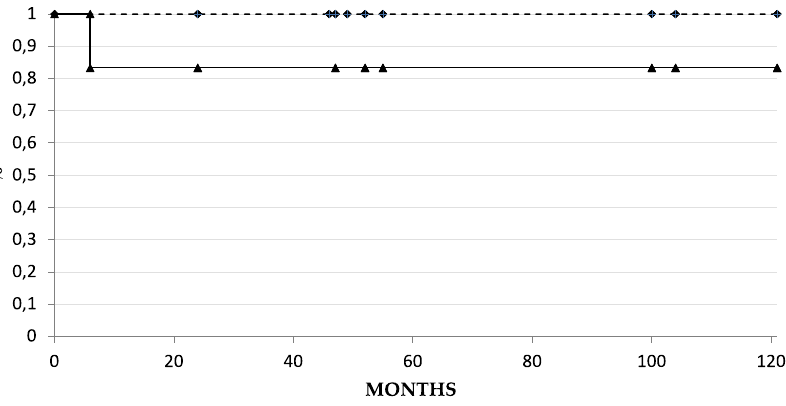
Figure 2. Kaplan-Meier survival analysis for surgical success. Solid line represents complete suc- cess (IOP ≤ 21 mmHg without glaucoma medications), dashed line represents qualified success (IOP ≤ 21 mmHg with or without glaucoma medications). Diamonds and triangles represent single patients at their last follow up